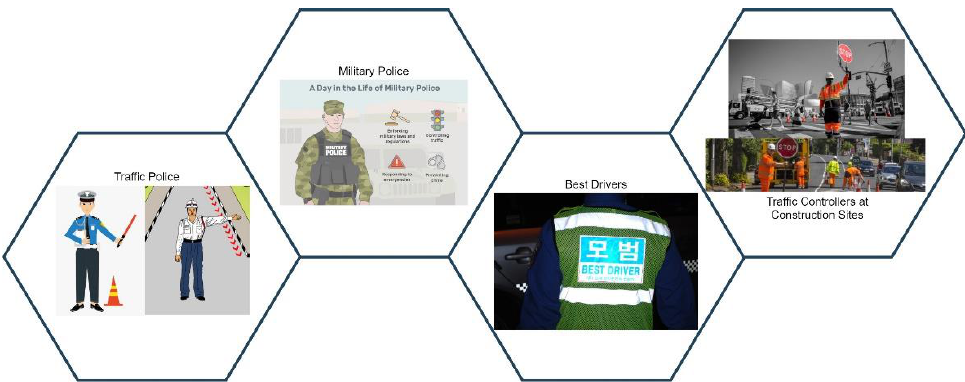
Figure 1. Examples of the possible controllers directing on-road traffic. Best drivers are considered as authorized traffic controllers (ATC) in South Korea.